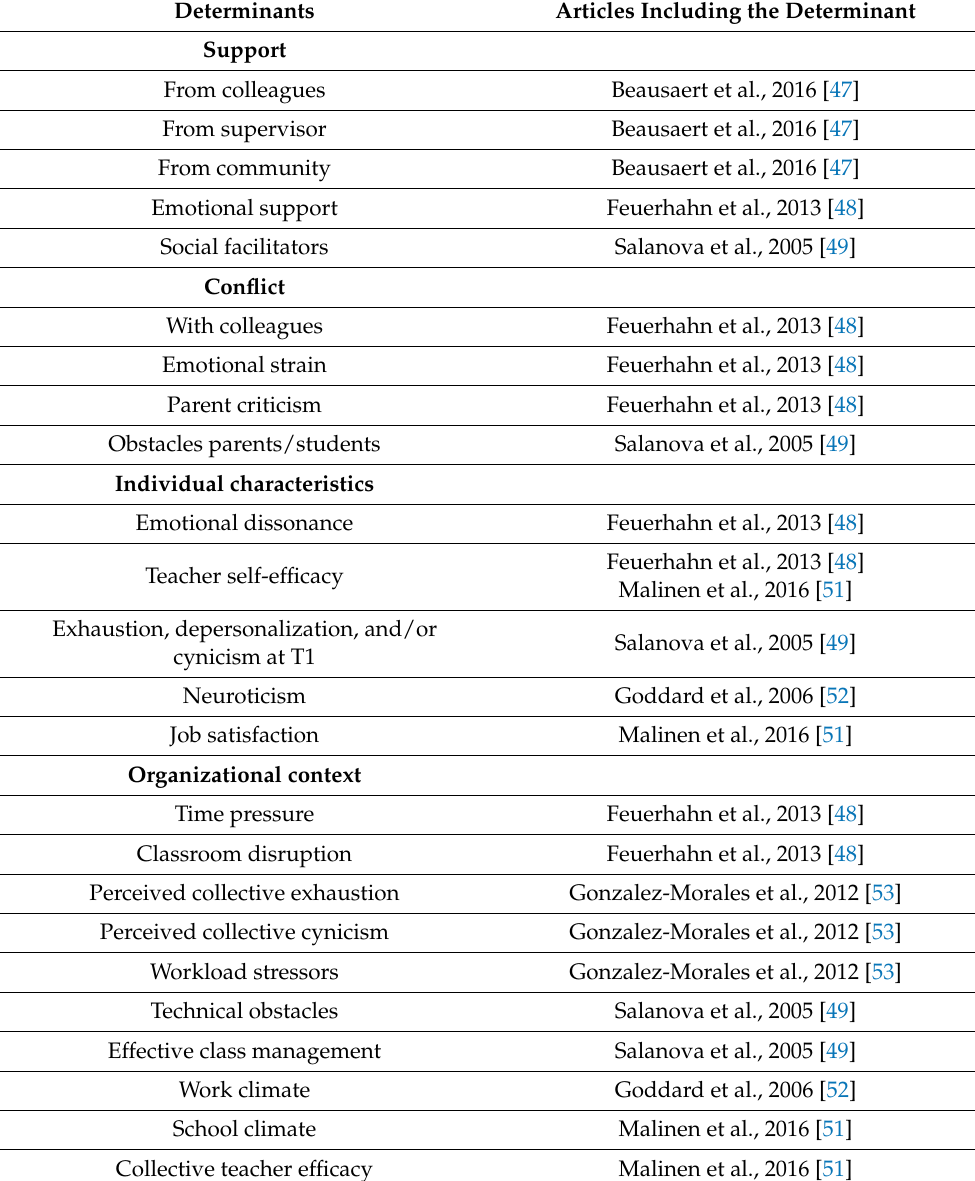
Table 3. List of burnout determinants analyzed via quantitative